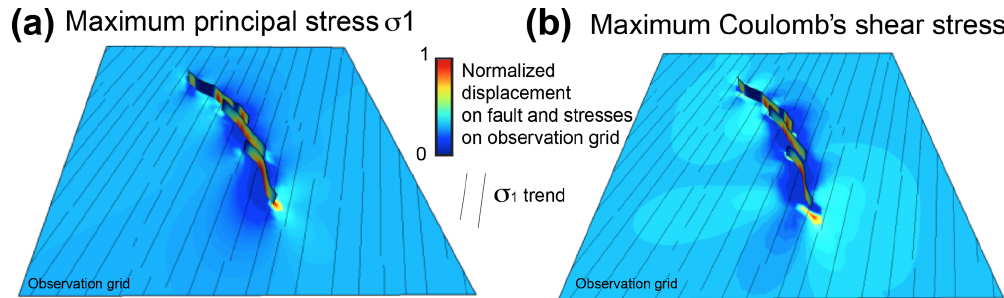
Figure 5. Examples of quasi-static stress distribution of σ 1 (a) and maximum Coulomb shear stress (b) around the Landers fault model, computed for θ = 110 ◦ , µ = 0 . 4, and C 0 =